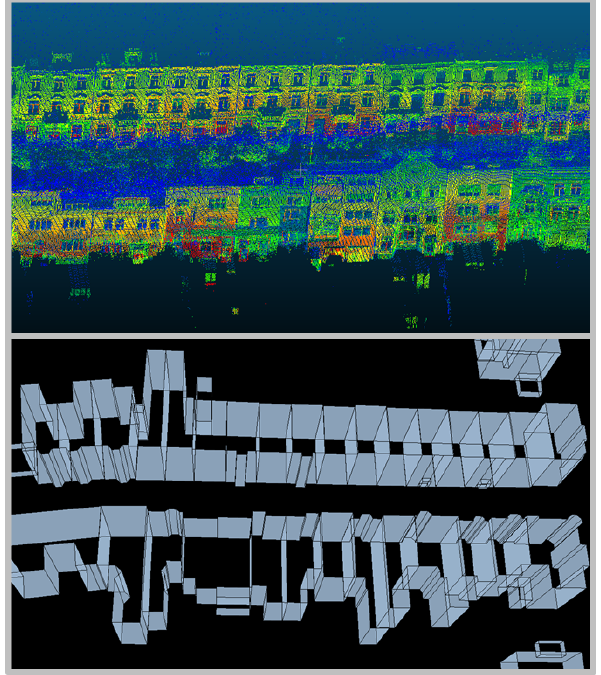
Figure 6. Input data: kinematic 3D point cloud (top) and the cor- responding 3D city model acquired from a WFS-Request (bot-